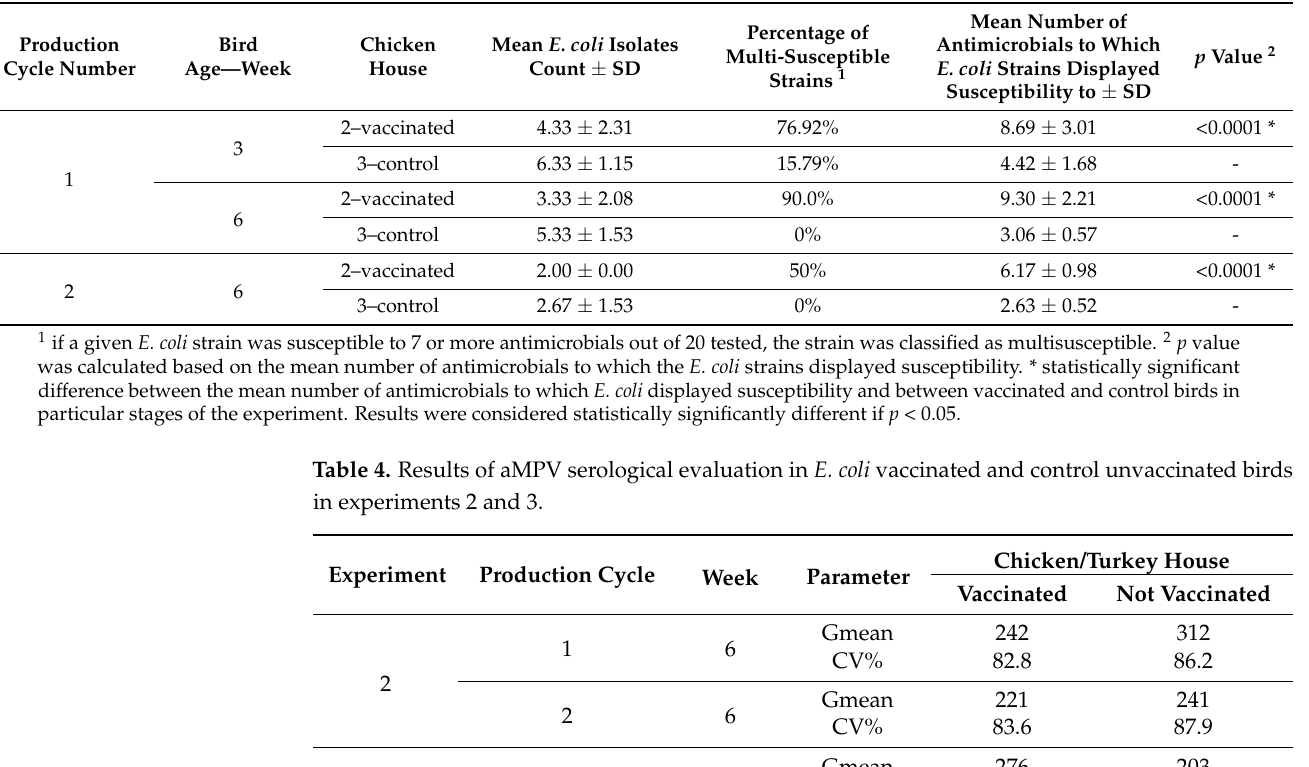
Table 3. Summarized results of microbiological studies from experiment 2.